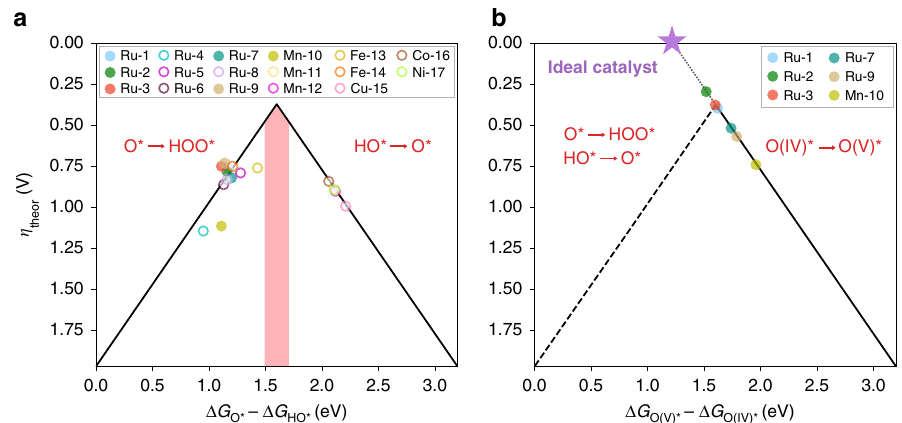
Fig. 4 2D-volcano representations featuring different OER descriptors. a Volcano plot using the conventional OER descriptor. Full markers denote catalysts which are theoretically predicted to undergo an additional ET step before O – O formation (see Supplementary Table 3). The red shaded area indicates the optimal range for the conventional OER descriptor. b Volcano plot including only the molecular catalysts predicted to undergo an additional ET. In this volcano, the calculated Gibbs energy for the additional ET from the M(IV)-oxo to M(V)-oxo intermediate is represented in the x -axis as a new OER descriptor. Note, the same scale and the left leg of the volcano in a has been used for comparability. The dotted line in b is drawn to guide the eye towards an ideal OER catalyst. The potential limiting step on each side of the two volcano plots is indicated in red